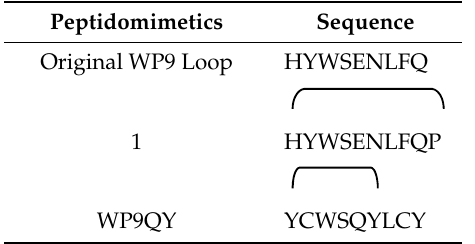
Figure 2. The chemical structure of the cyclic peptides 1 and WP6QY. Table 1. Sequence comparison of original WP9 loop and anti-TNF α peptidomimetics.